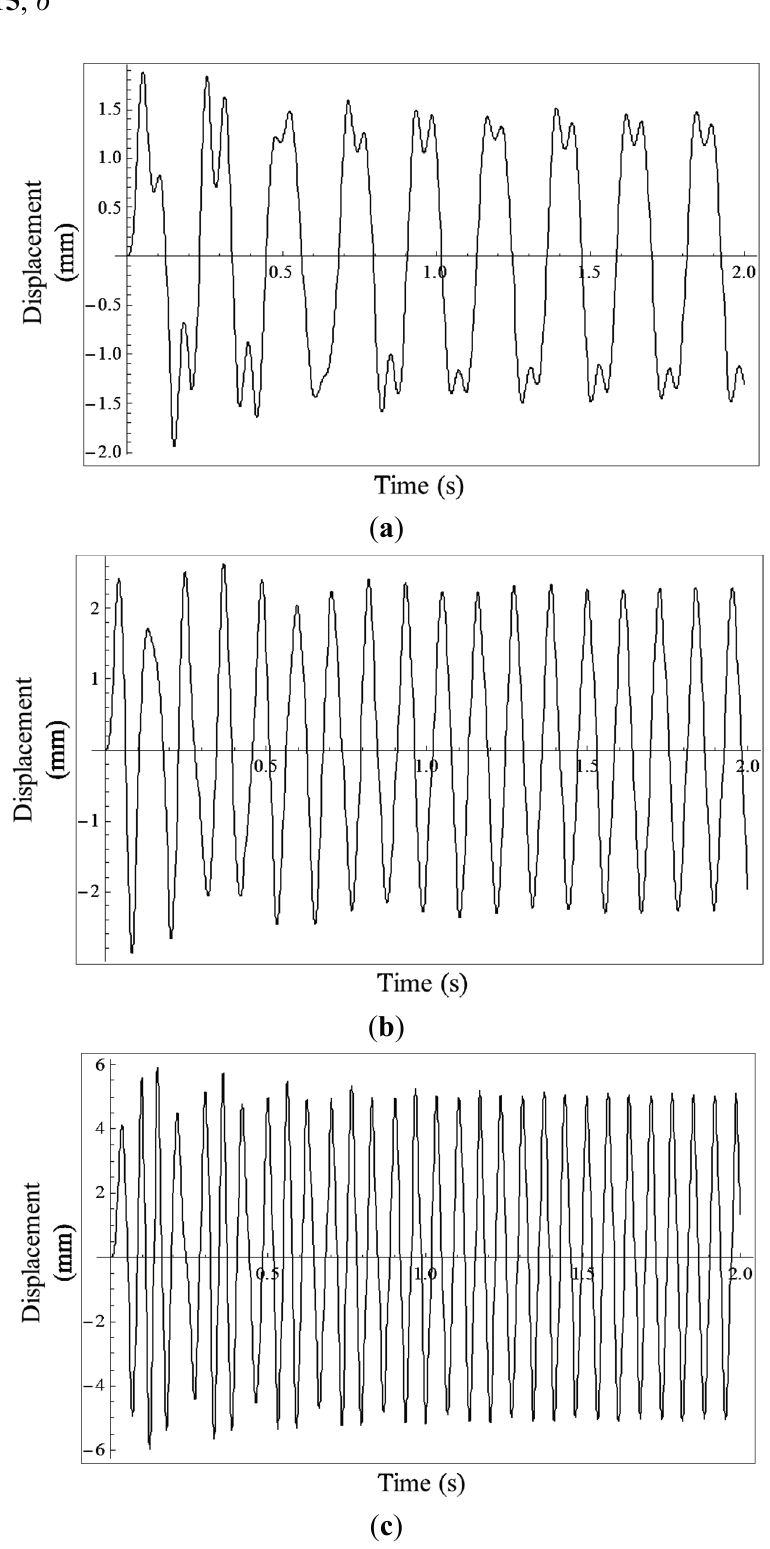
Figure 4. Displacement variations of the proof mass at different car speeds: ( a ) 30 km/h, ( b ) 60 km/h, and ( c ) 100